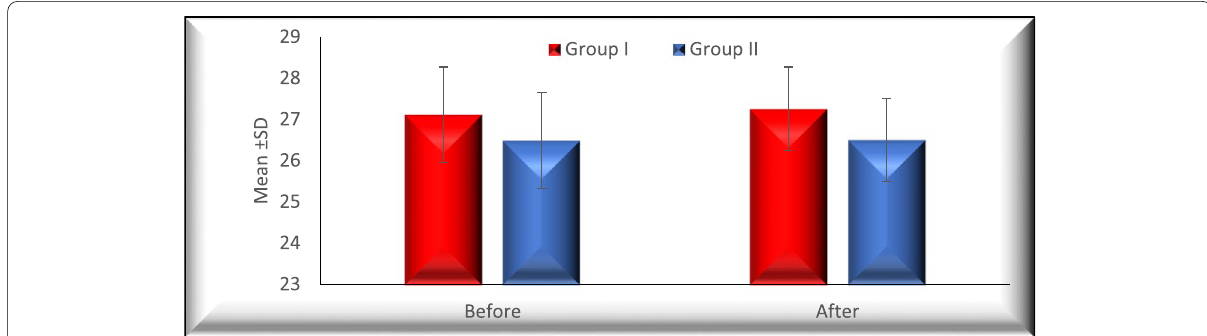
Fig. 1 Comparison between each group before and after treatment and the two studied groups according to BMI